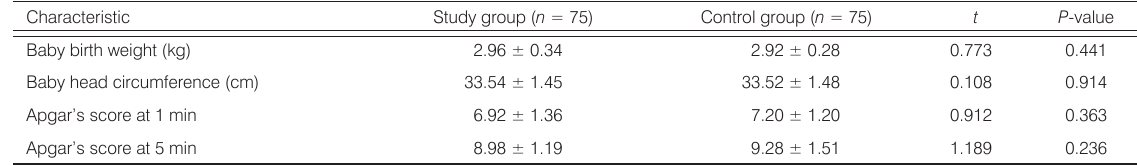
Table 4. Neonates’ outcome between the two groups (M